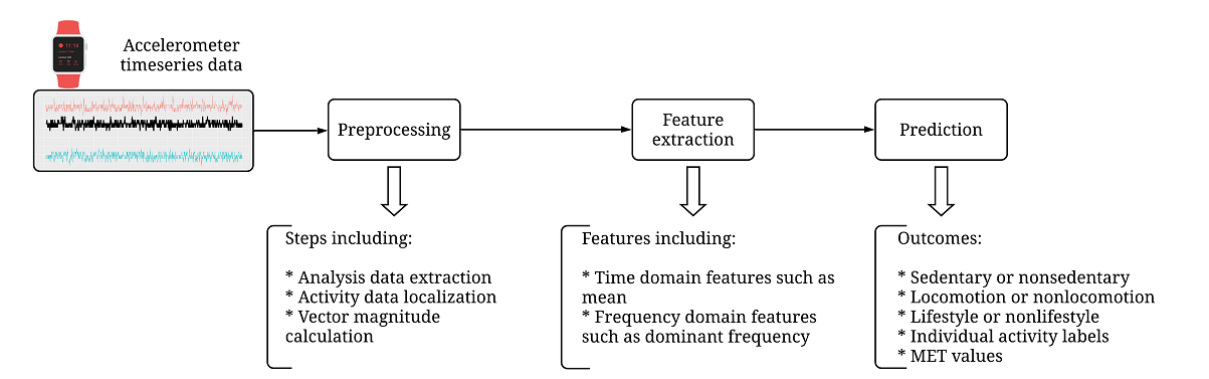
Figure 2. Analysis flow steps. After accelerometer data were downloaded using the ActiLife (ActiGraph) toolbox, preprocessing steps and feature extraction steps were completed to prepare the data set to be used in prediction models for each task. MET: metabolic